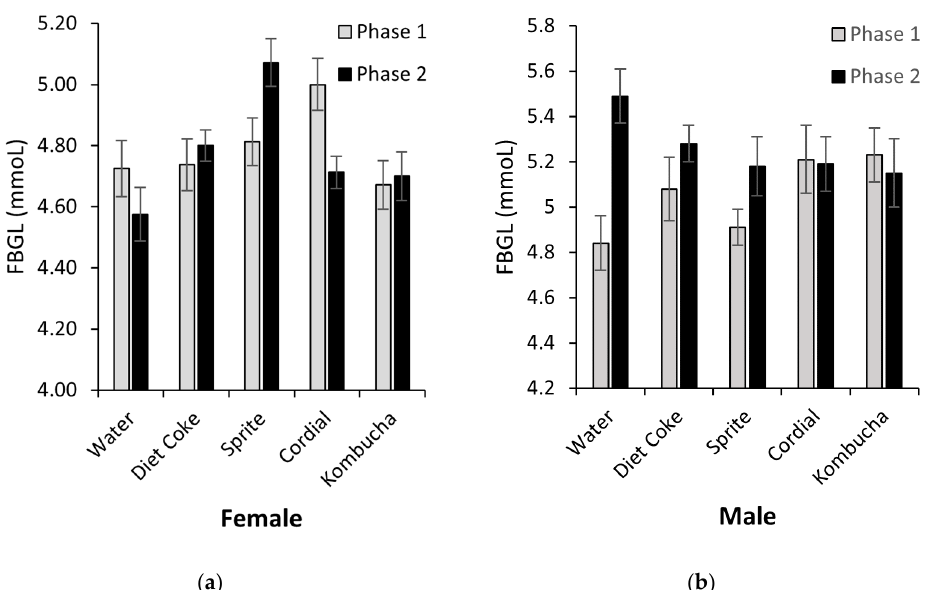
Figure 6. Fasting blood glucose levels measured at the end of Phases 1 and 2 for female ( a ) and male rats ( b ). Female Sprite group’s FBGLs increased between the tests ( p = 0.012) and were significantly higher than in the other groups ( p = 0.04). Male Sprite and control groups’ FBGLs increased between the tests ( p < 0.34) ( n = 8/sex/group).